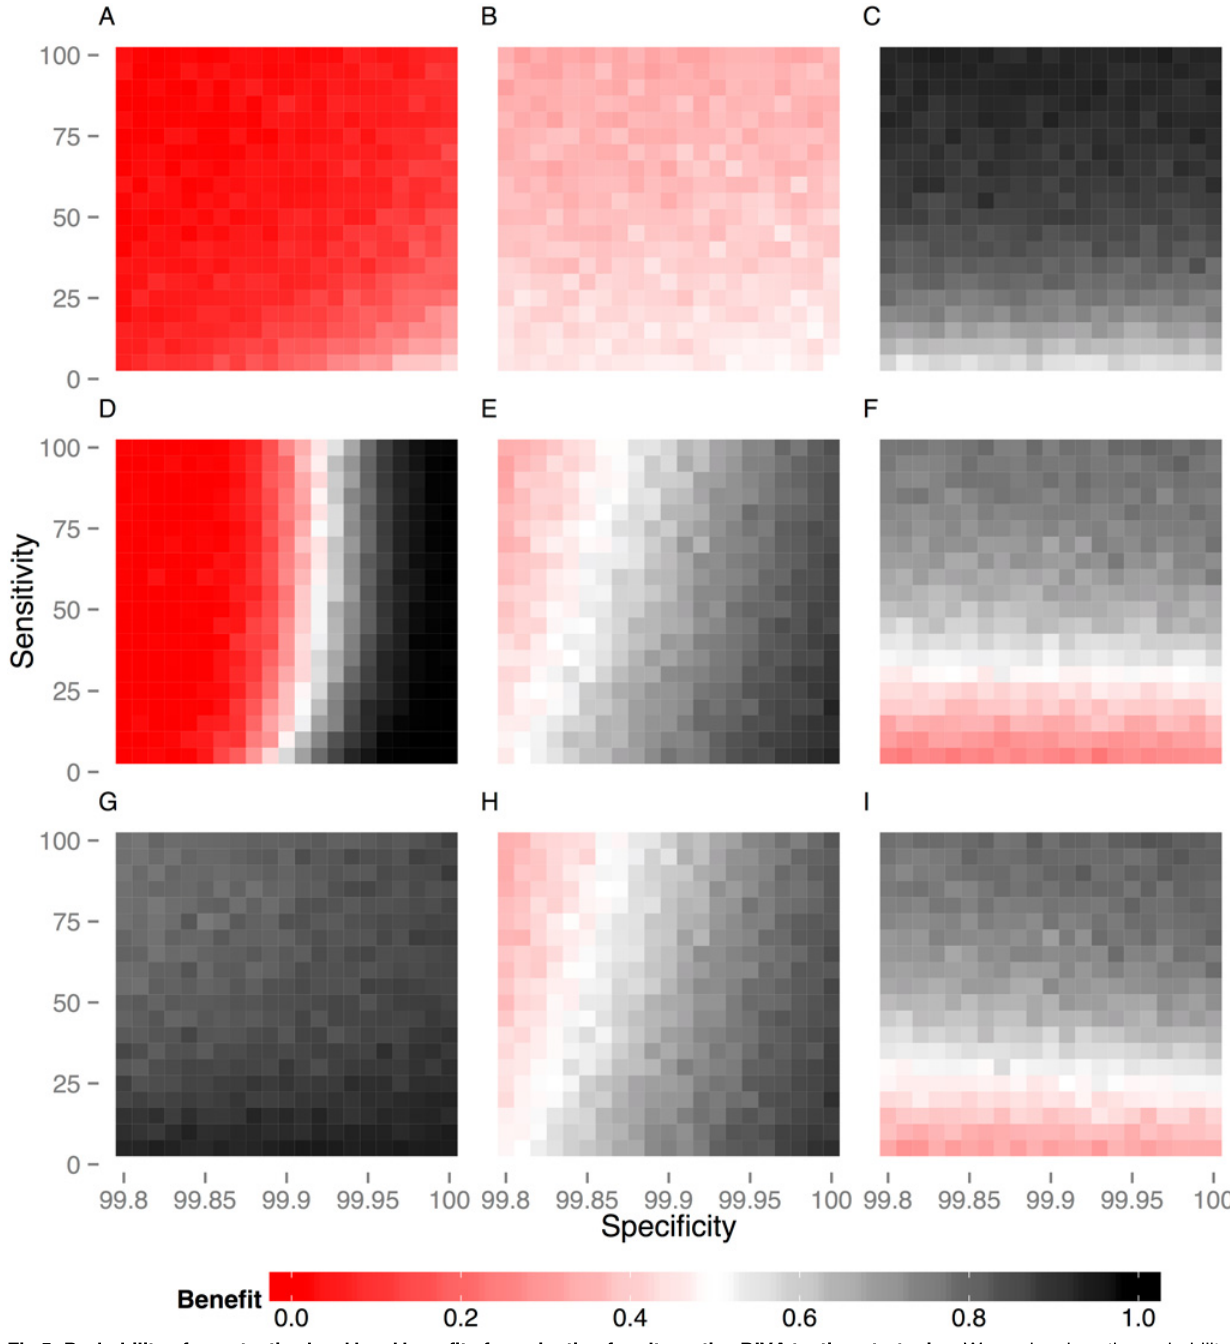
Fig 5. Probability of a protective herd level benefit of vaccination for alternative DIVA testing strategies. We explore how the probability of seeing a protective benefit of vaccination depends on the assumed sensitivity and specificity of DIVA testing. The probability of benefit is calculated for a singleton challenge of infection and relative to the current statutory regime of tuberculin testing and slaughterhouse surveillance. Benefit is estimated from 100 simulations of our study population (6,601 herds) for three key measures (across columns): the total number of tests required to clear restrictions ( A,D,G ), the probability of restrictions being applied before the herd clears infection ( B,E,H ) and the probability of infection remaining in a herd when restrictions are lifted ( C,F,I ). We define the break-even point as 50% of herds demonstrating a protective benefit illustrated by the white band in the color map with red values worse this threshold and grey points better. We compare the three strategies described in the main text (across rows): ( A,B,C ) Under the DIVA negation scenario, the break-even point is limited by the considerable overhead in testing, with an increased probability of restrictions being applied before the herd clears infection ( B ) and an increase in testing ( A ) even for a 100% sensitive and specific DIVA test. ( D,E,F ) Under DIVA replacement, a protective benefit of vaccination can be achieved for DIVA specificities > 99.90% ( D ). The break-even point also depends on DIVA sensitivity, with a sensitivity of at least 40%